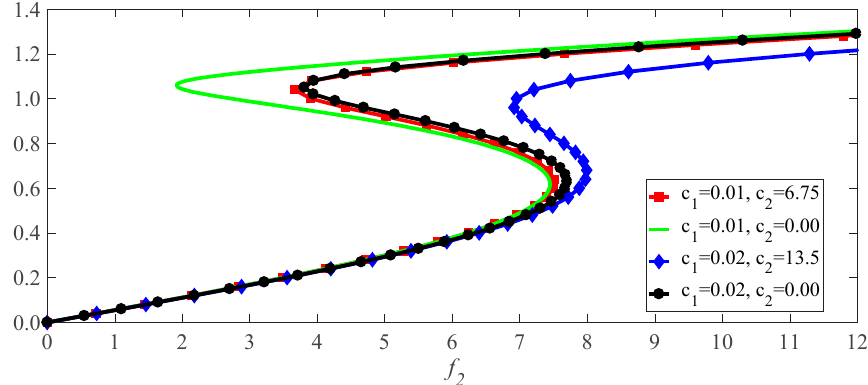
Figure 4. Amplitude of the response as a function of the excitation amplitude of primary resonance with σ = 10 for several damping parameters.